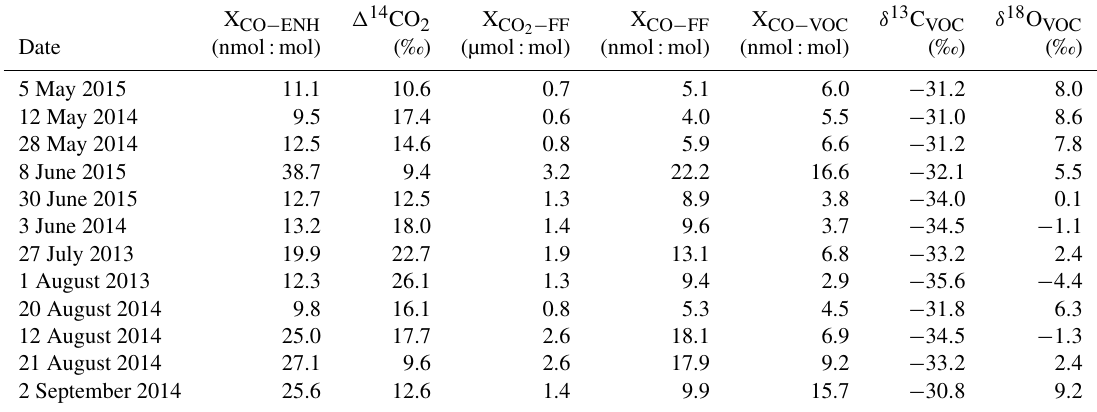
Table 2. VOC signature calculation table using data from Indianapolis, Indiana, US. (cid:49) 14 CO 2 and X CO Turnbull et al. (2015, 2019). X CO − ENH 1 σ uncertainty is ± 0.7nmol:mol, (cid:49) 14 CO 2 1 σ uncertainty is ∼ ± 1 . 8‰ (Turnbull et al., 2015, 2019), and X CO 1 σ uncertainty is ± 1µmol:mol (Turnbull et al., 2015, 2 − FF